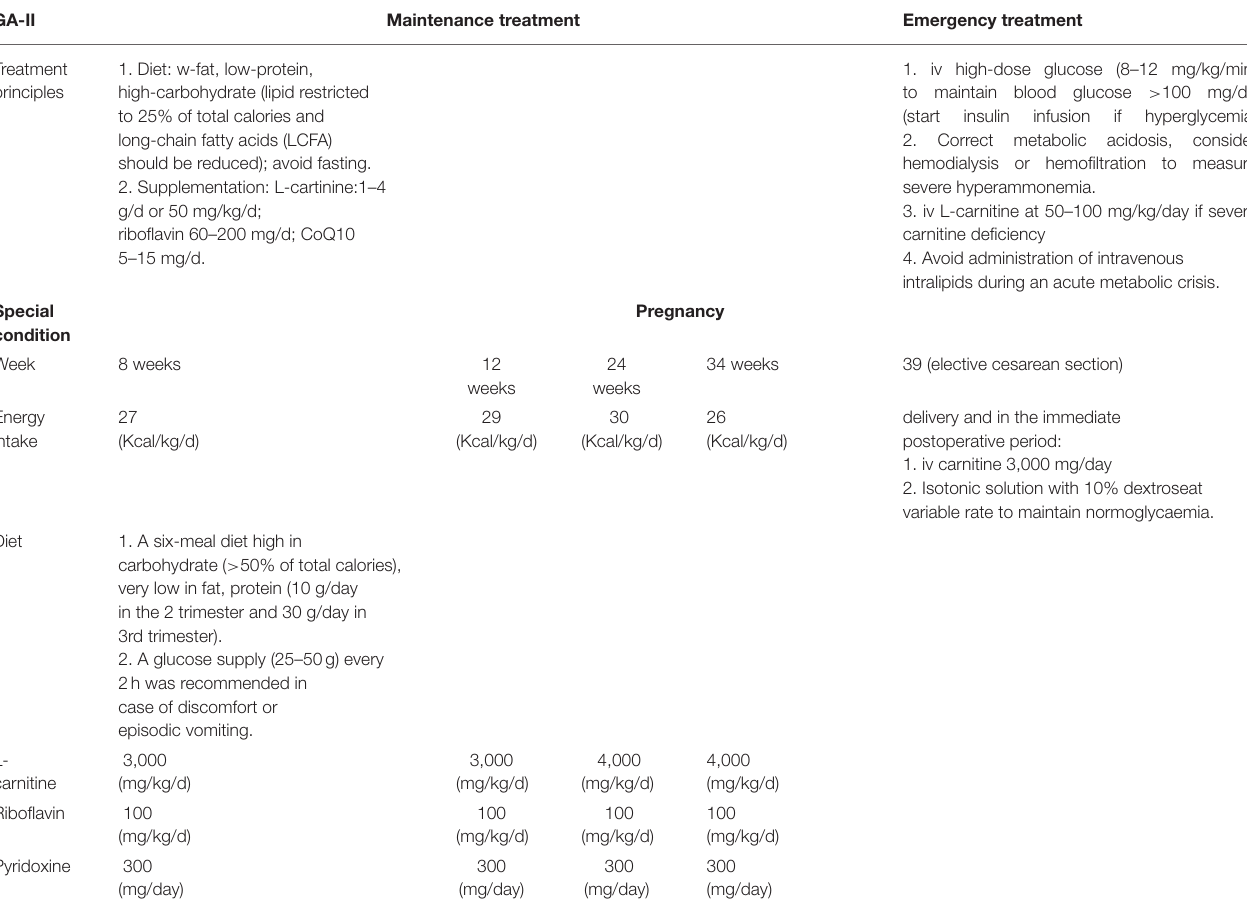
TABLE 2 | The currently treatment strategies of GA-II. GA-II Maintenance treatment Emergency